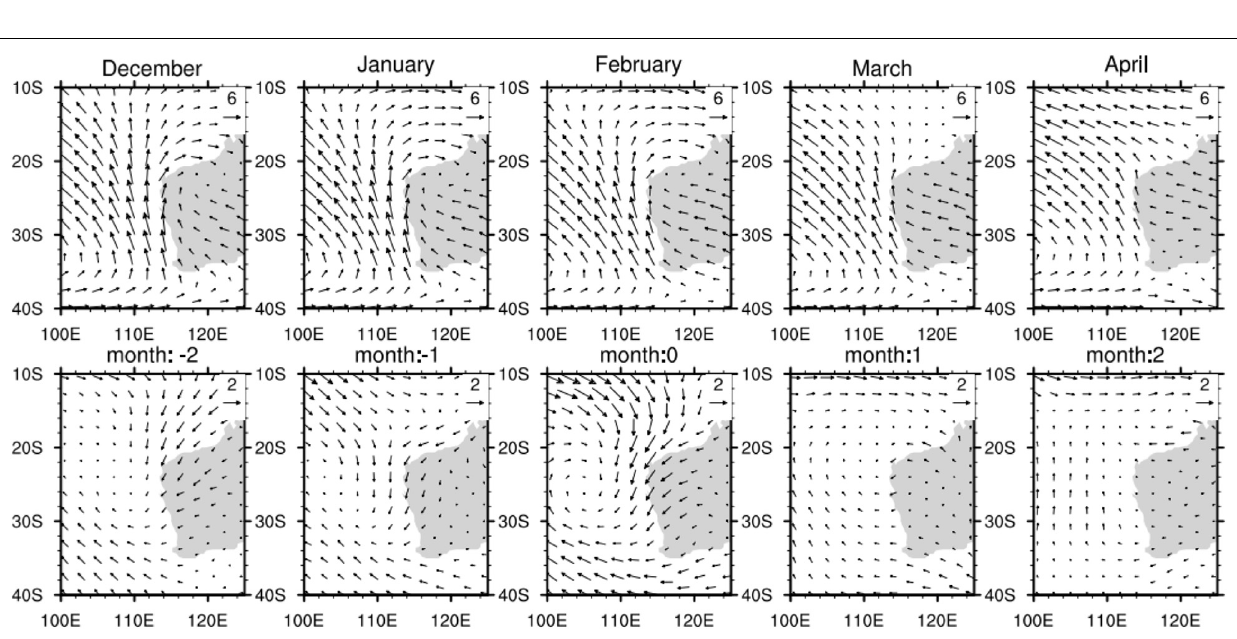
Frontiers in Marine Science |